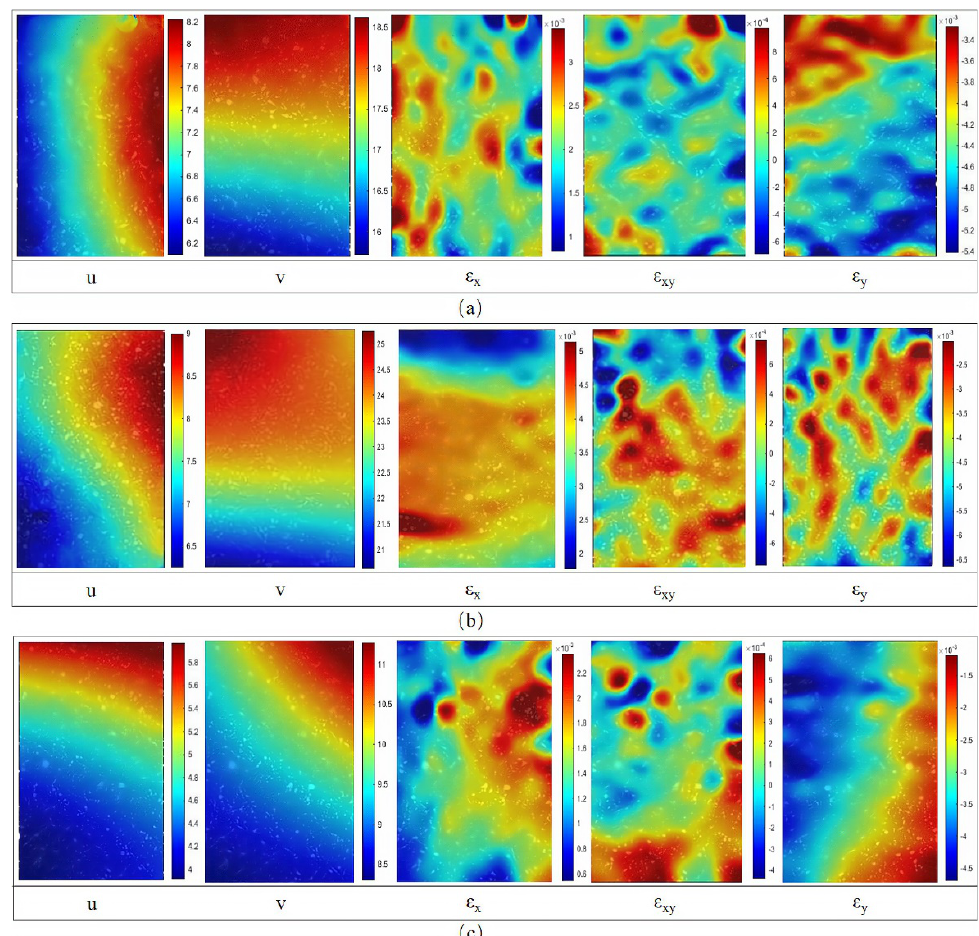
Figure 11. Displacement field and strain field of each specimen before failure in the compression failure test without cracks: ( a ) specimen S0, ( b ) specimen A0, ( c ) specimen D0.